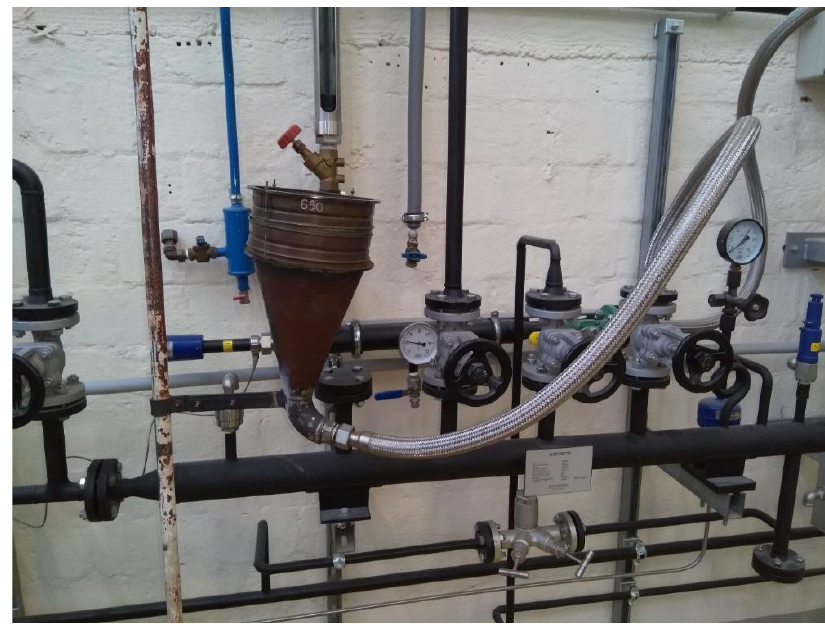
Figure 5. Sample pieces (numbering from the upper left corner).